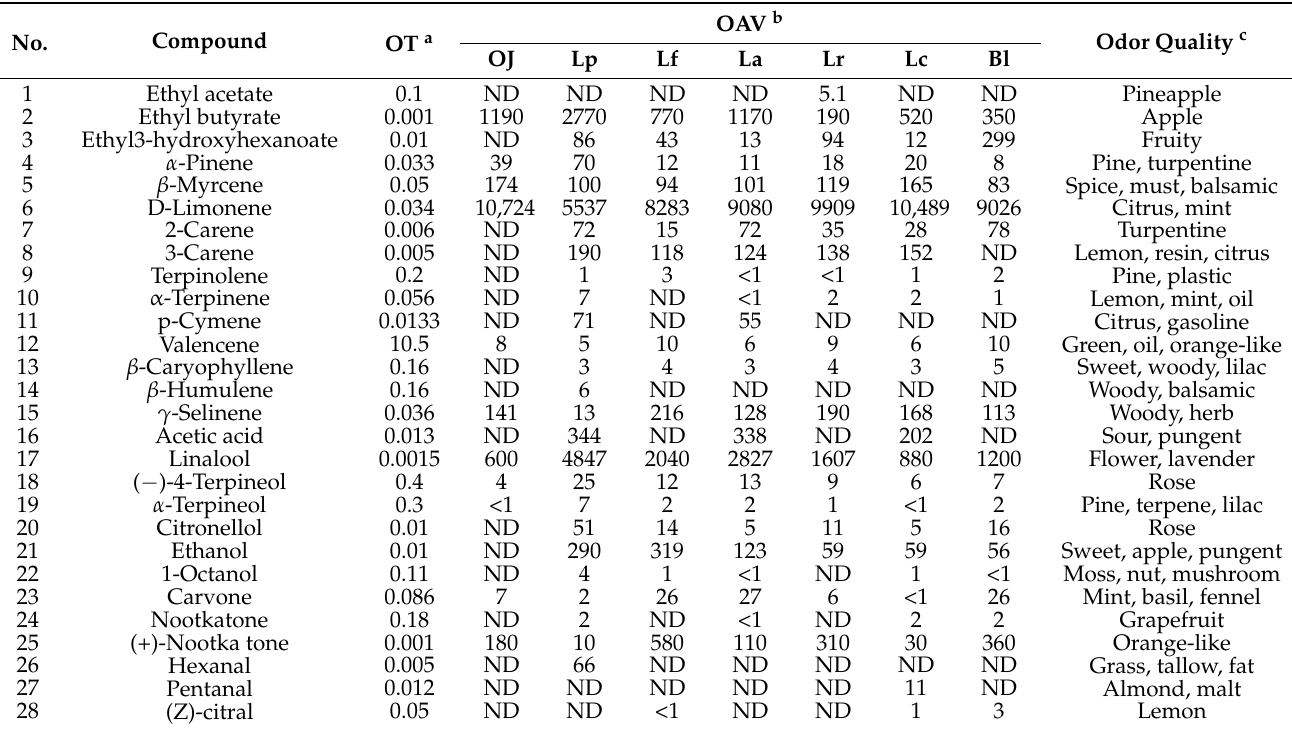
Table 3. OAVs of aroma-active compounds with OAV ≥ 1 in fermented orange juices and control ( n =